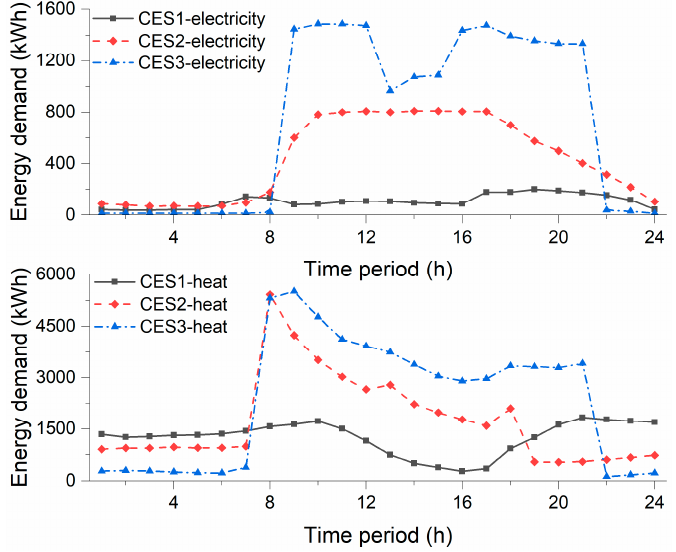
Figure 2. Load profiles in each CES.